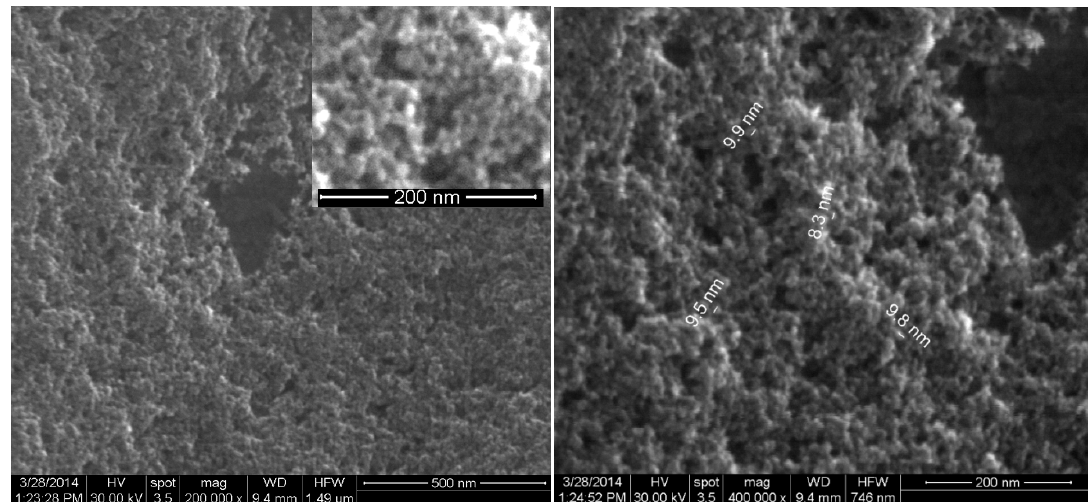
O @CV powder. 3 4